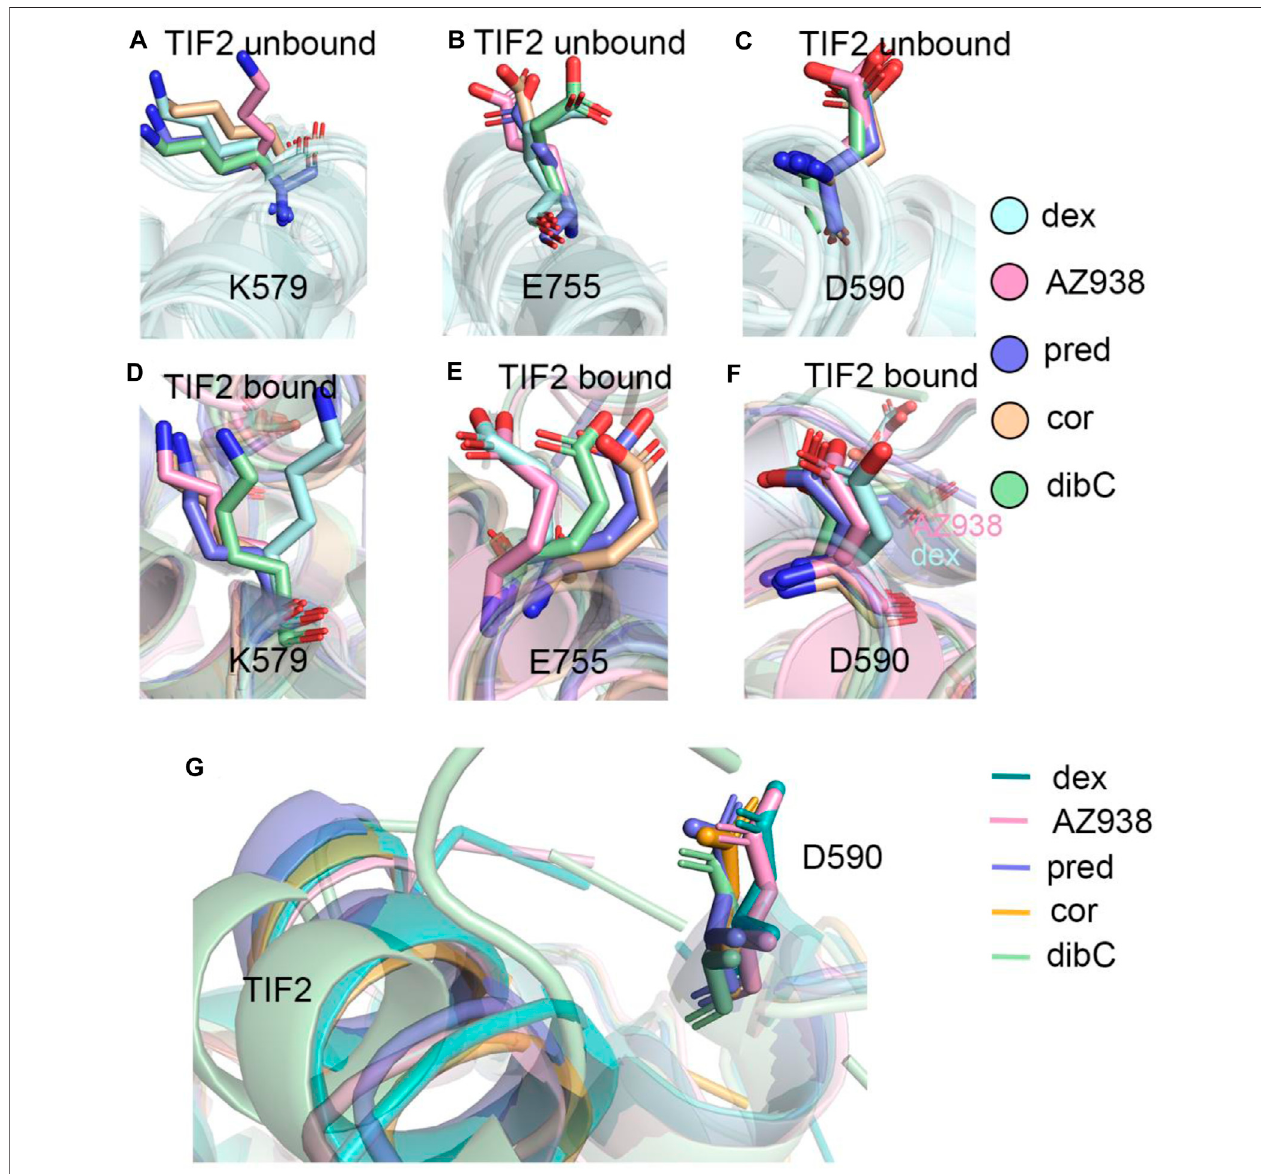
FIGURE 6 | (A) representative structures of K579 in the TIF2-unbound systems. (B) representative structures of E755 in the TIF2-unbound systems. (C) representative structures of D590 in the TIF2-unbound systems. (D) representative structures of K579 in TIF2-bound systems. (E) representative structure of E755 in TIF2-bound systems. (F) representative structure of D590 in TIF2-bound systems. (G) representative structure of TIF2 and D590 in TIF2-bound systems.